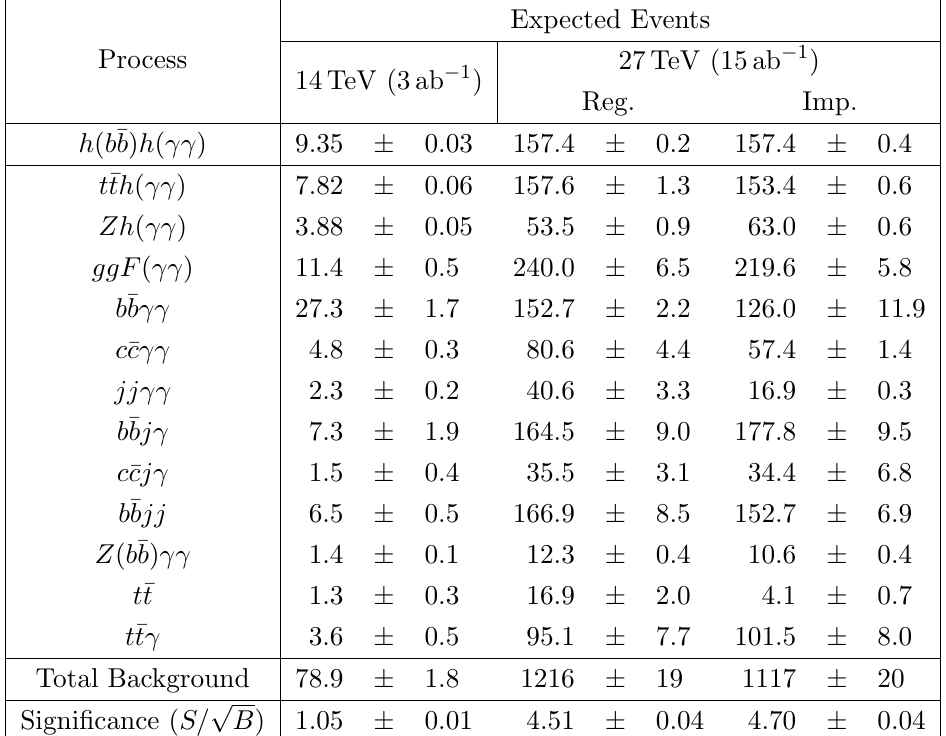
Table 4. The expected number of events from each signal/background process at 14 and 27 TeV based on MC simulation, using the cross sections shown in table 3. Also shown are the total background and signi(cid:12)cance (computed as S= p B ) at each energy.